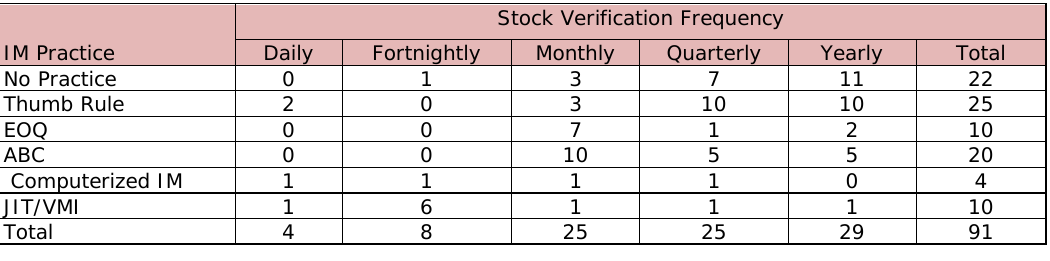
Table 3. “IM Practice and Stock Verification